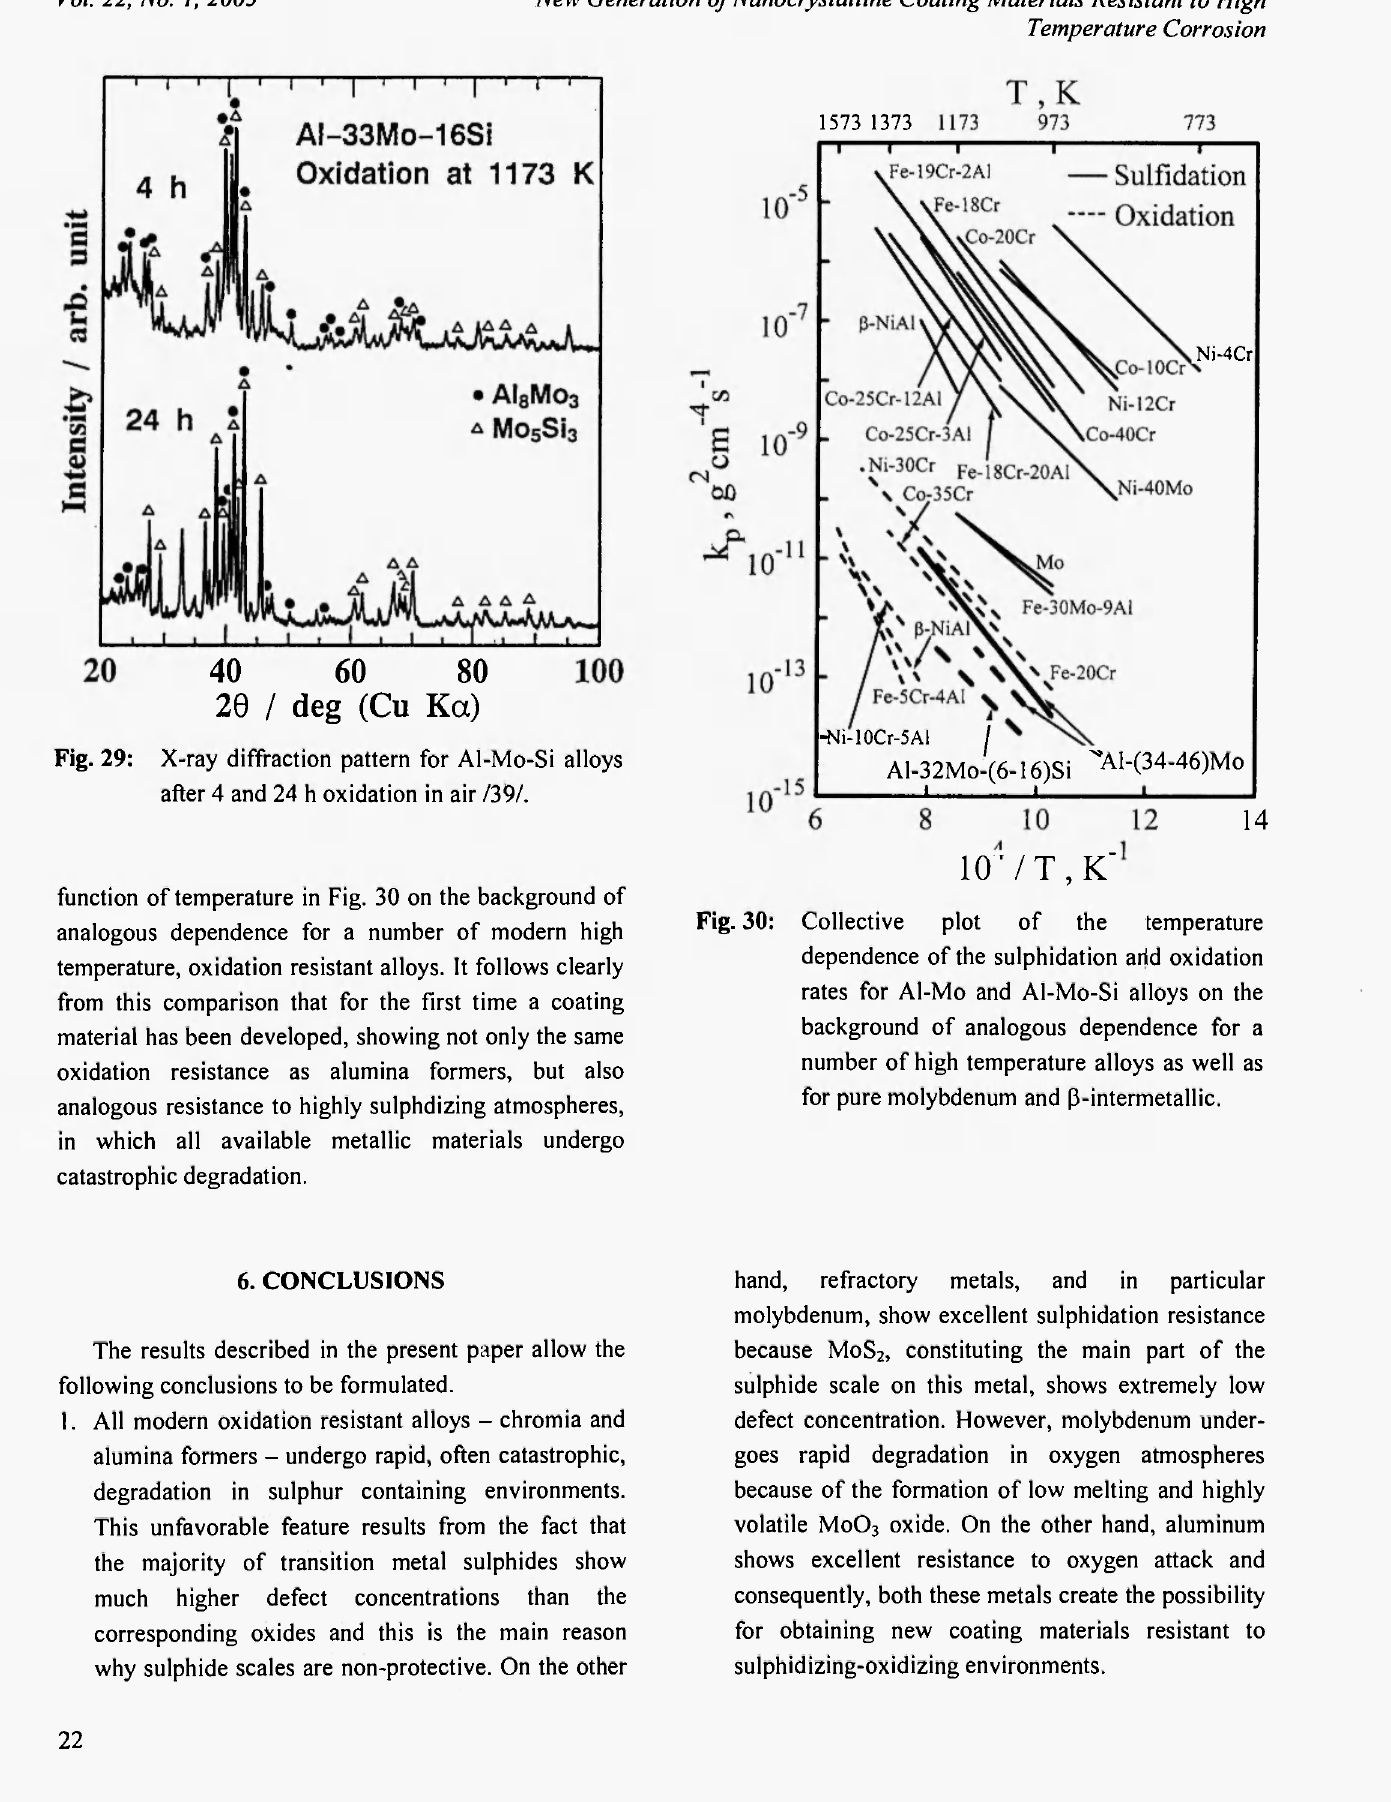
Fig. 30: Collective plot of the temperature dependence of the sulphidation arid oxidation rates for Al-Mo and Al-Mo-Si alloys on the background of analogous dependence for a number of high temperature alloys as well as for pure molybdenum and